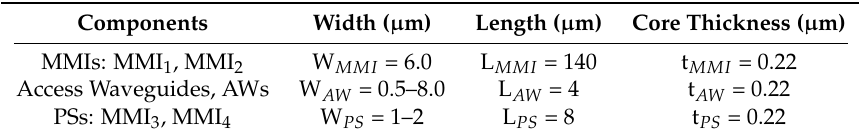
Table 1. Geometrical parameters of the 3-dB splitters/couplers, access waveguides (AWs), and phase shifters (PS) obtained from simulation. The symbols W, L, and t denote width, length, and thickness of the device, respectively. Optical parameters used for simulation include substrate, Si (n = 3.48), lower cladding, SiO 2 (n = 1.45), core, Si (n = 3.48), and upper cladding, air (n =